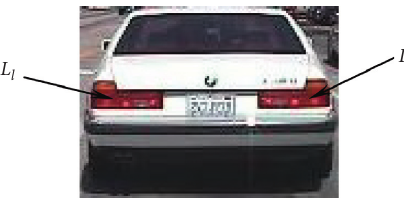
Figure 2: Structure image of taillight pairs of vehicle.